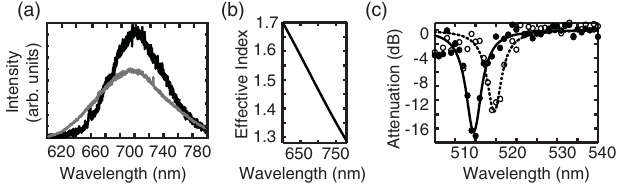
FIG. 7. (a) Normalized spectra of the NV via confocal collection (black) and the SiN waveguide fluorescence (gray) under 532-nm excitation. (b) Effective index of the waveguide mode. (c) Laser attenuation from DBR filters integrated into similar single-mode waveguides measured in